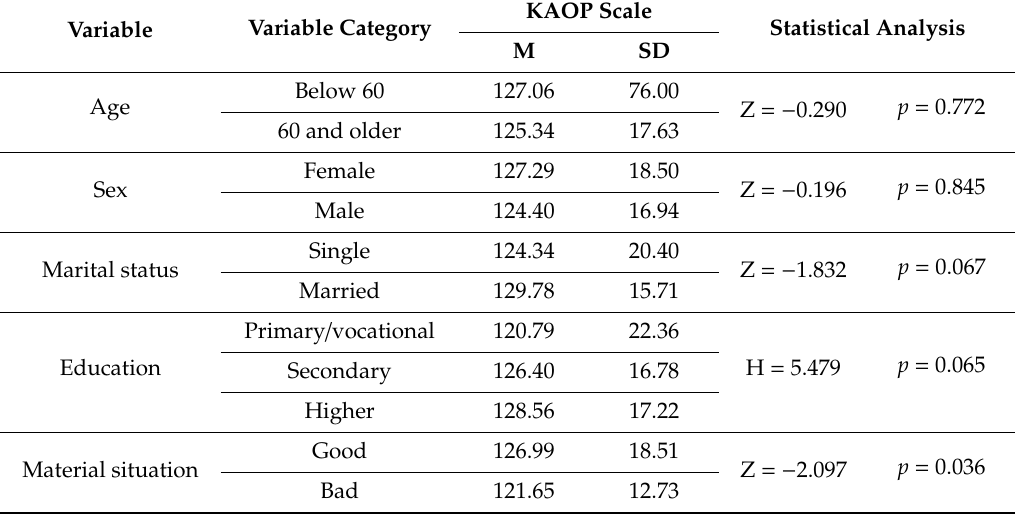
Table 3. Attitudes within the research cohort toward the